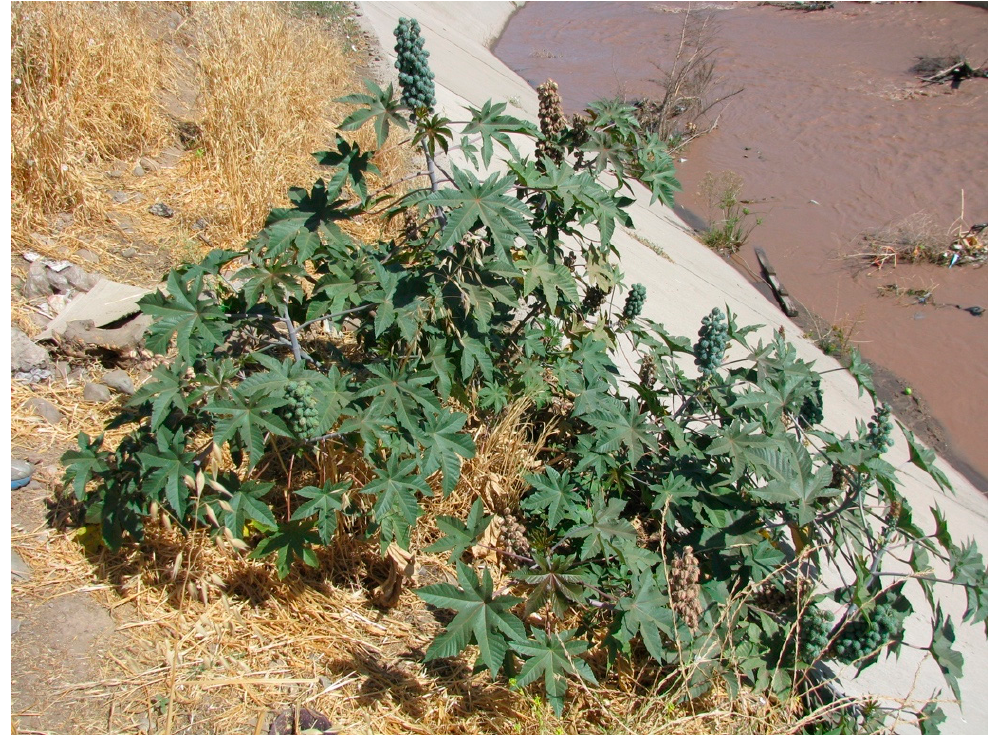
Figure 4. Wild castor bean ( Ricinus communis L.) growing near a body of water in San Joaquín, Metropolitana region, Chile. (33°28 ′ 50 ″ S; 70°37 ′ 51 ″ W).